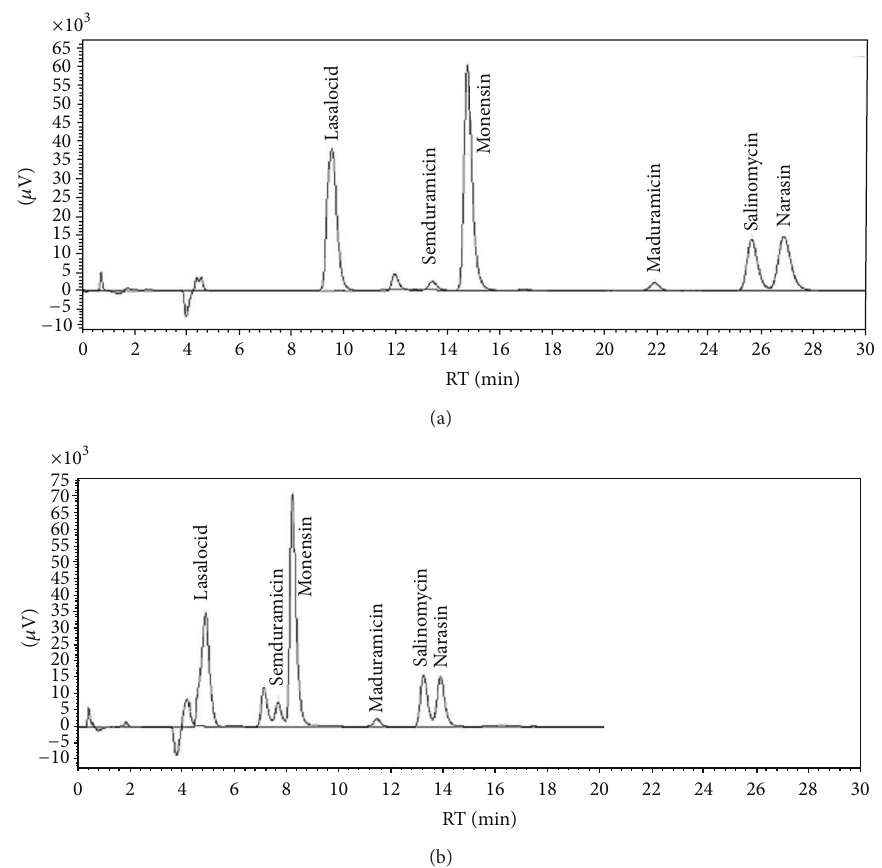
Figure 2: The comparison of the separation of six ionophore coccidiostats with traditional porous column and fused core technology. (a) Chromatogram obtained on Phenomenex Luna C18(2) column ( 150 × 4.6 mm, 3 𝜇 m) with gradient elution of methanol (A) and 0.02 M KH 2 PO 4 (B) 0–10min: 88% A, 14–19min: 90% A, 22–32 min: 88% A; flow rate 0.7 mL/min. (b) Chromatogram obtained on Phenomenex Kinetex C18 column ( 150 × 4.6 mm, 2.6 𝜇 m) with isocratic elution with methanol and 0.02 M KH 2 PO 4 (88: 12, v : v ); flow rate 0.7